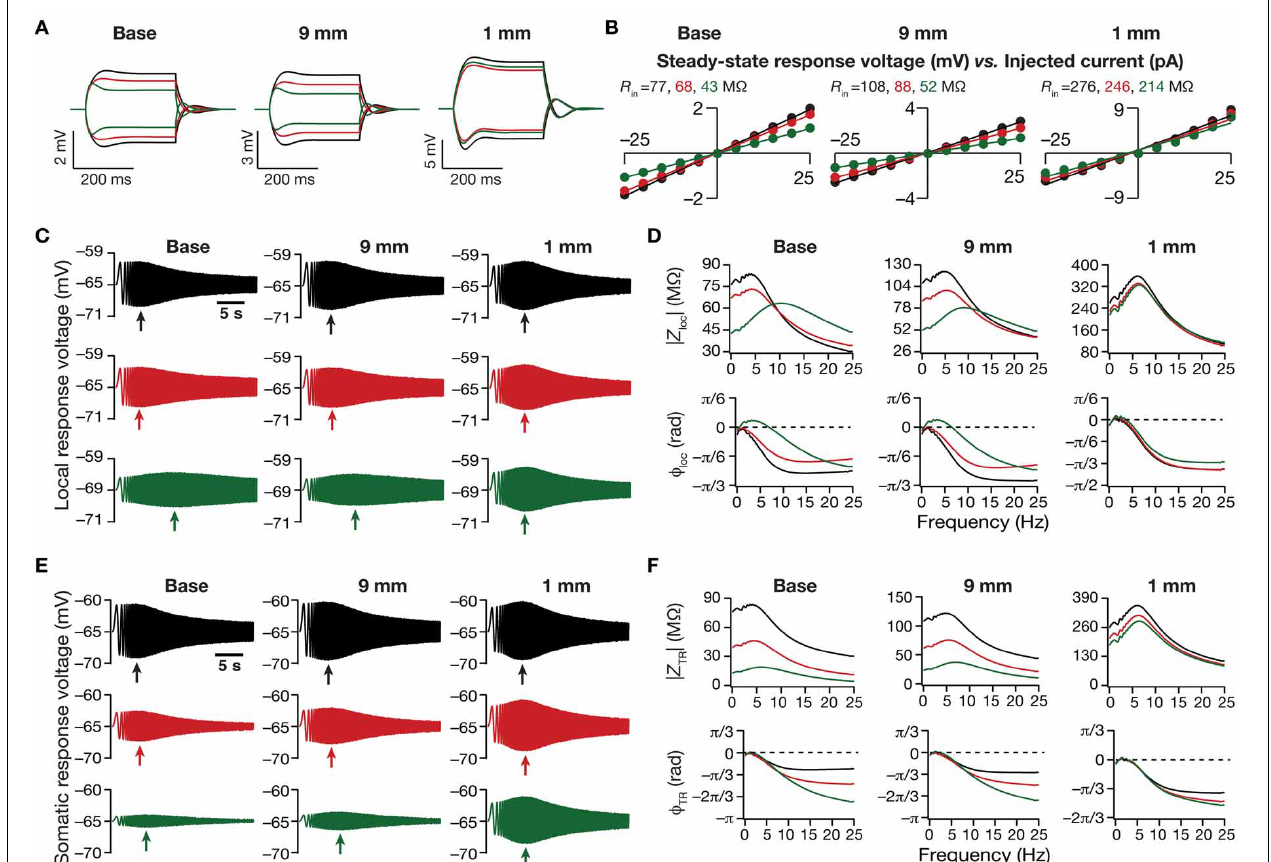
FIGURE 3 | Dendritic atrophy in the presence of a physiologically constrained HCN-channel gradient introduced significant somatodendritic changes in neuronal intrinsic response dynamics. (A,B) Local voltage traces (A) and steady-state V – I plots (B) fitted with straight lines obtained in response of depolarizing and hyperpolarizing current pulses injected at three identical locations on three different morphological reconstructions. (C) Local voltage traces obtained in response of a chirp stimulus injected at three identical locations on three different morphological reconstructions. (D) Local impedance amplitude (top) and phase (bottom)